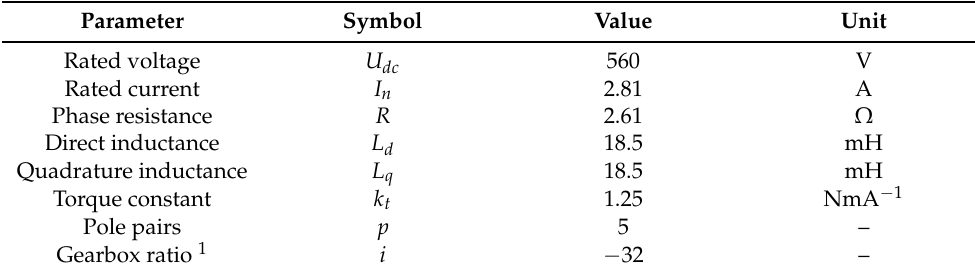
Table A1. Parameters of the measured actuator.